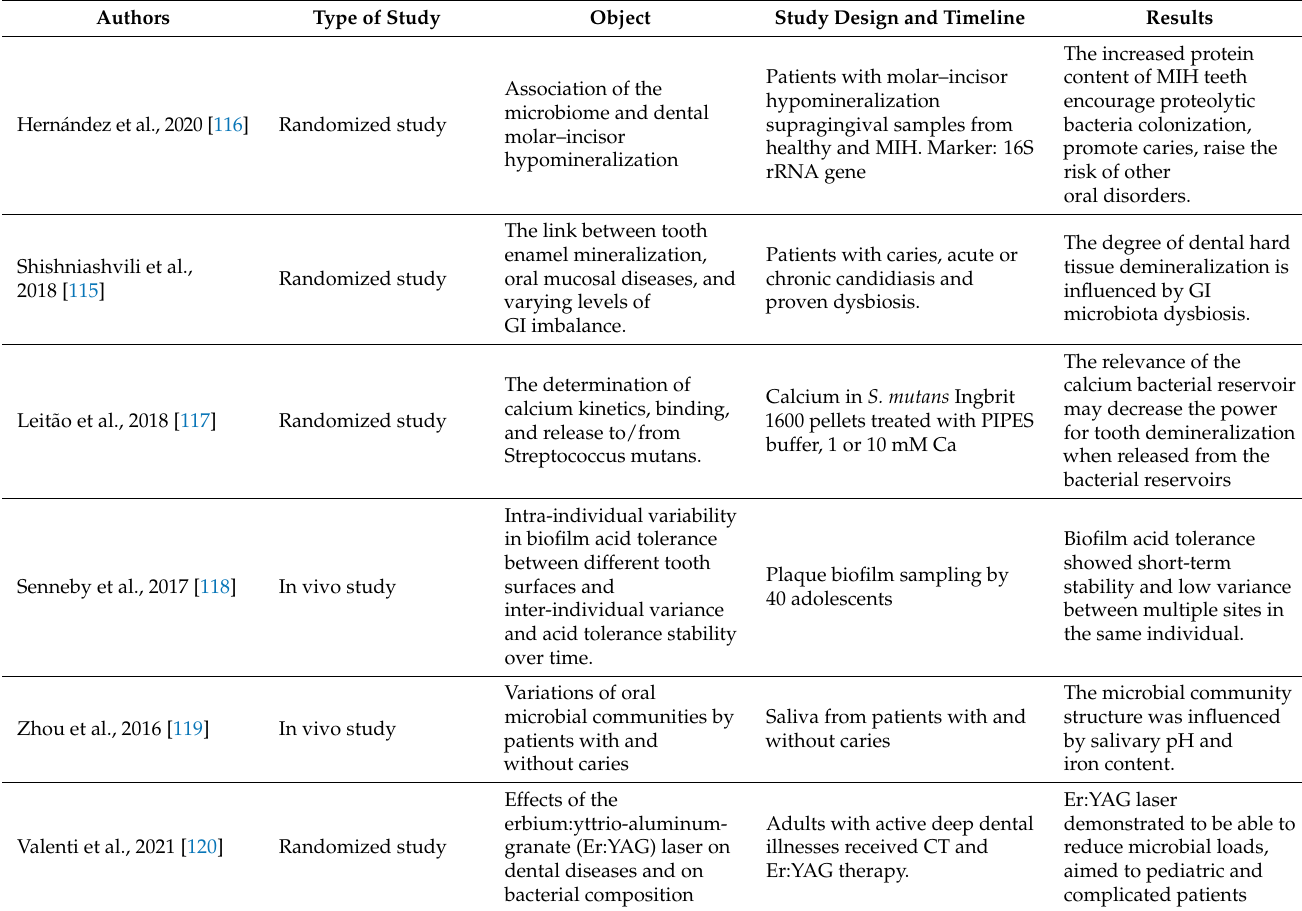
Table 4. Primary studies that examined demineralization [MIH: Molar incisor